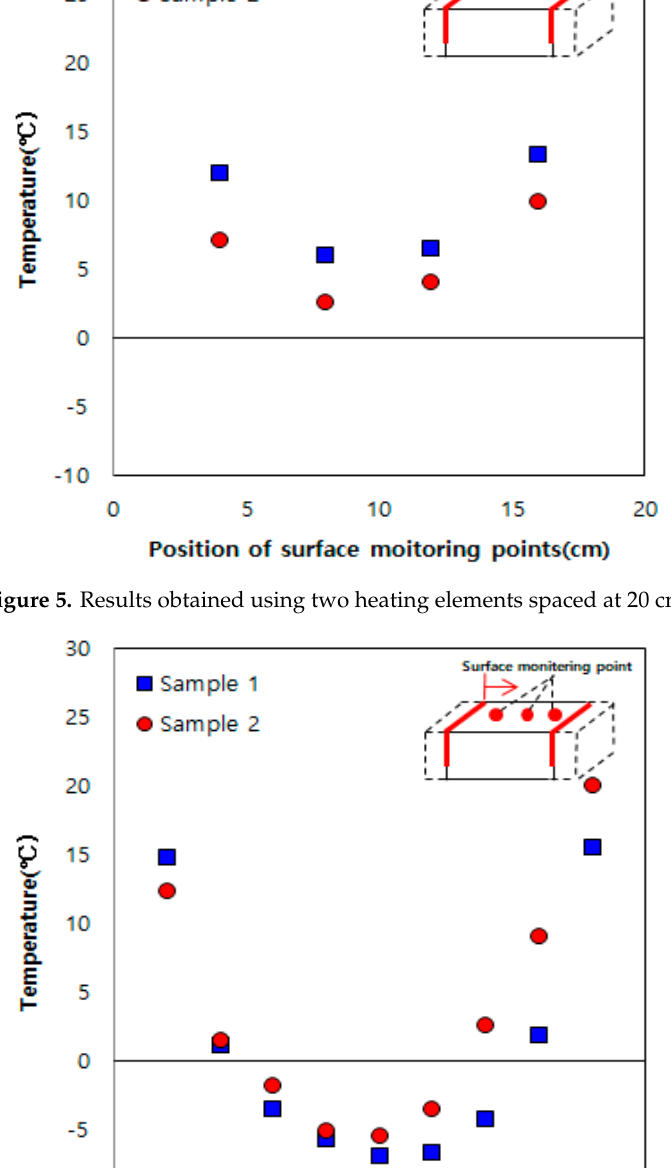
Figure 4. Results obtained using two heating elements spaced at 15 cm.